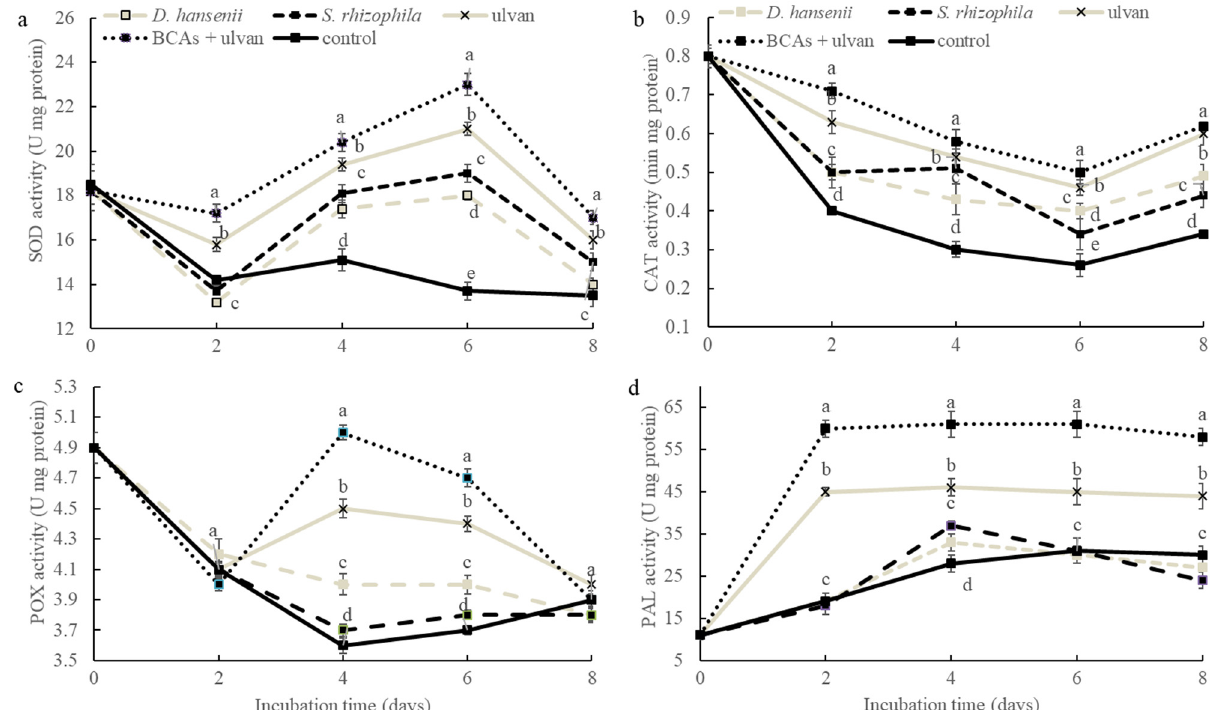
Figure 3. Effect of D. hansenii , S. rhizophila and ulvan on the antioxidant enzymatic activity on muskmelon fruit. BCAs = Biological control agents ( D. hansenii + S. rhizophila ). Each value is the mean of five replicates with three fruits per replicate ± Standard deviation. Different letters indicate significant difference ( p ≤ 0.05). ( a ) superoxide dismutase (SOD) estimation; ( b ) catalase (CAT) estimation; ( c ) peroxidase (POX) estimation; ( d ) superoxide dismutase (SOD) estimation.